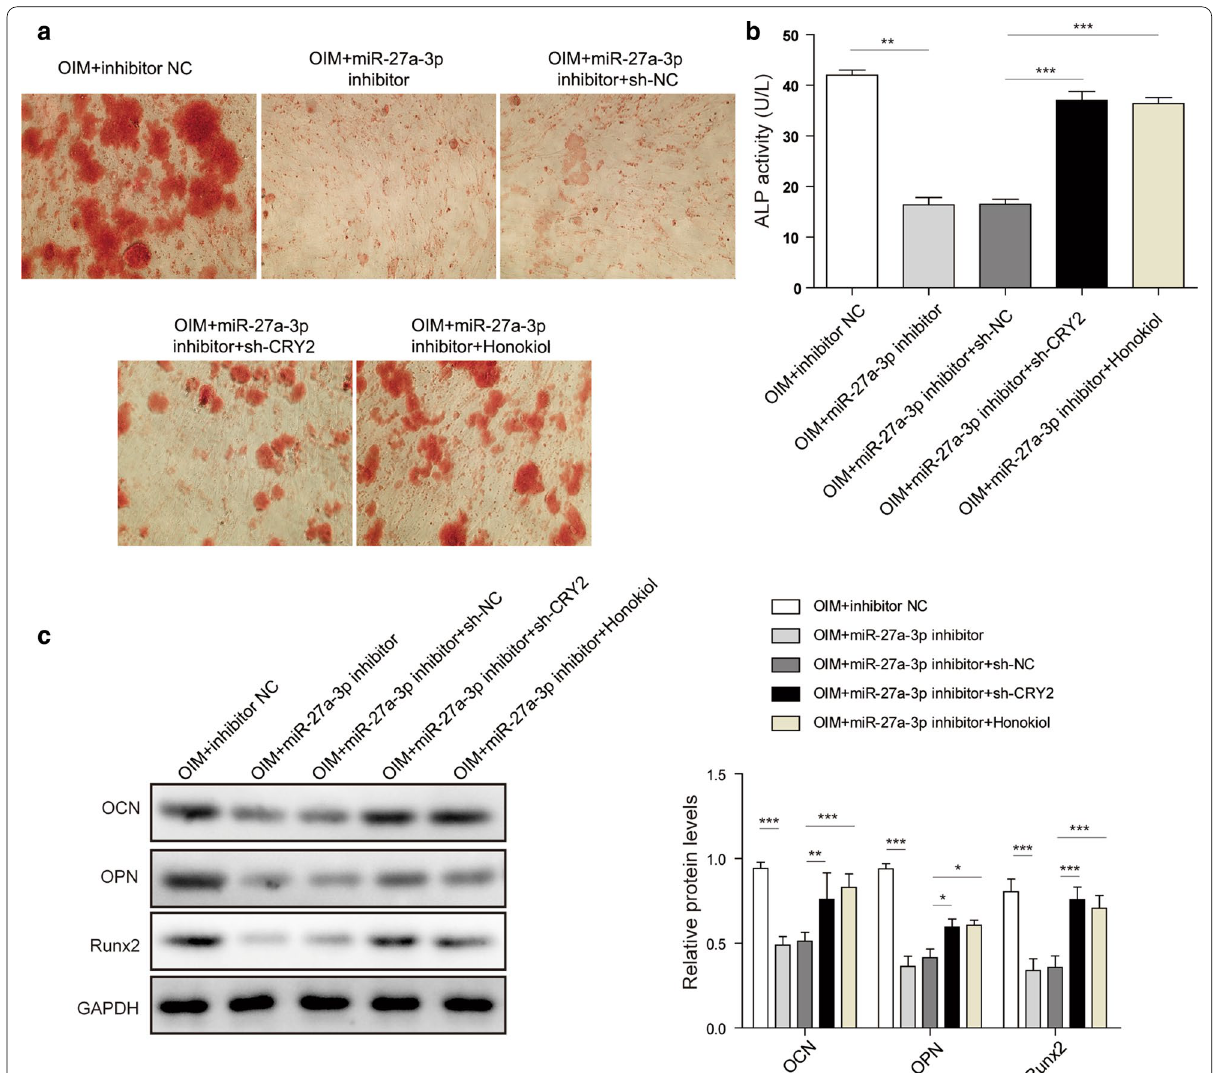
Fig. 4 MiR‑27a‑3p regulated CRY2/ERK1/2 signal axis to promote ODM. MC3T3‑E1 cells were treated with miR‑27a‑3p inhibitor or CRY2 shRNA. a Alizarin Red staining in MC3T3‑E1 cells. b Detection of ALP activity; c Western blotting analyzed the expression of OCN, OPN and RUNX2. *P < 0.05, **P < 0.01, ***P <